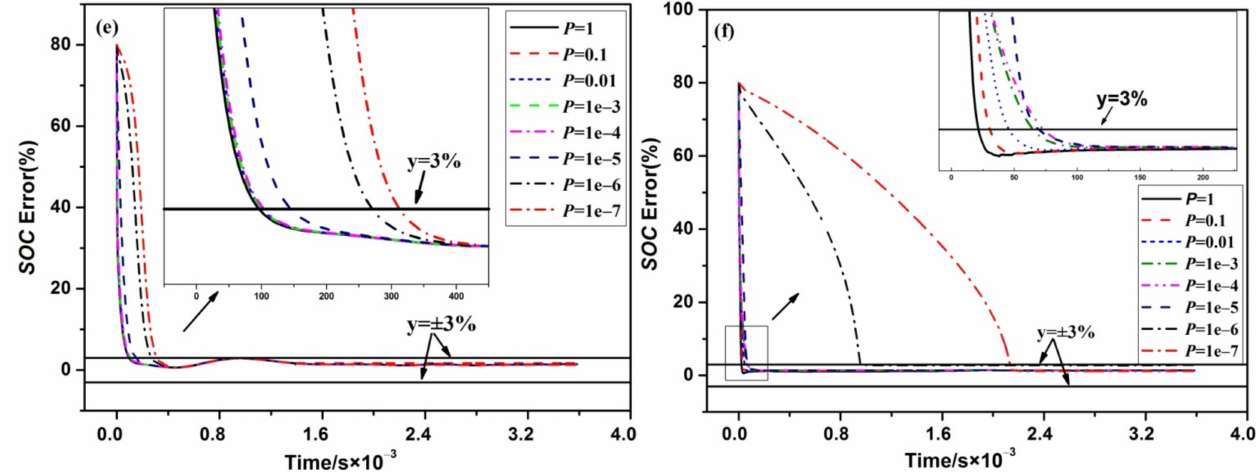
Figure 5. The estimation curve of SOC error under different P 0 : ( a ) EKF algorithm at initial SOC = 1, ( b ) ISH I algorithm at initial SOC = 1, ( c ) IIAE algorithm at initial SOC = 1, ( d ) EKF algorithm at initial SOC = 0.2, ( e ) ISH I algorithm at initial SOC = 0.2, ( f ) IIAE algorithm at initial SOC =